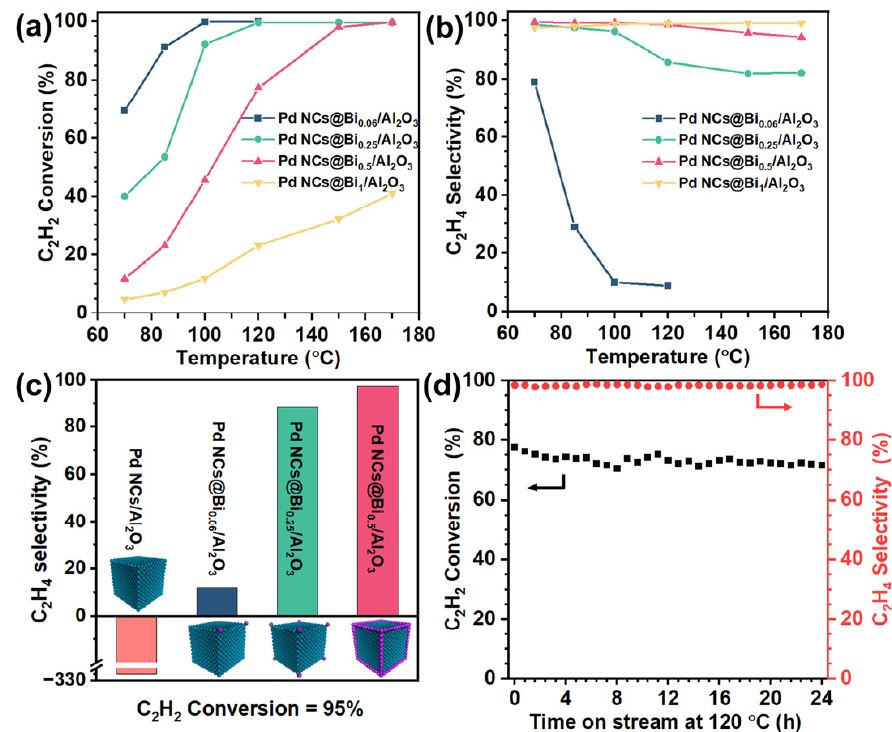
Figure 3. Catalytic performances of Pd NCs@Bi/Al 2 O 3 in acetylene hydrogenation. ( a ) C 2 H 2 conversion and ( b ) selectivity to C 2 H 4 , ( c ) the selectivity to C 2 H 4 for 95% C 2 H 2 conversion over different catalysts, ( d ) long − term stability test of Pd NCs@Bi 0.5 /Al 2 O 3 at 120 °C. (Reaction conditions: space velocity of 120,000 mL h − 1 g − 1 and reactant gases: 1.0 vol % C 2 H 2 , 20.0 vol % C 2 H 4 , 20.0 vol % H 2 and 59.0 vol % N 2 ).